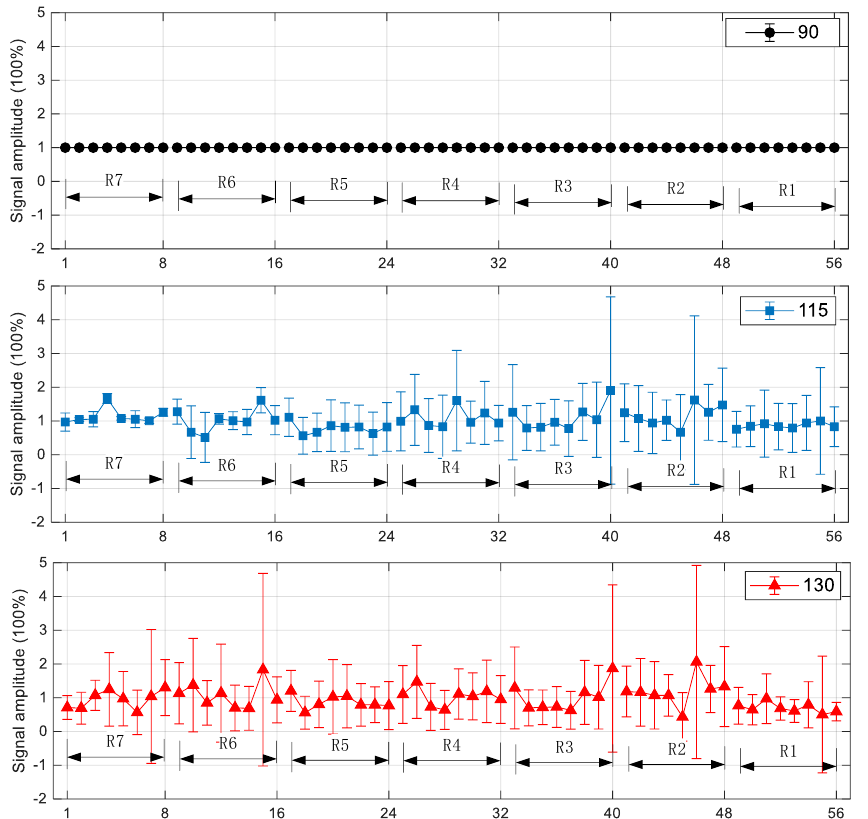
Figure 12. Means values and deviations of the signals with heating temperatures of 90, 115, and 130 °C.